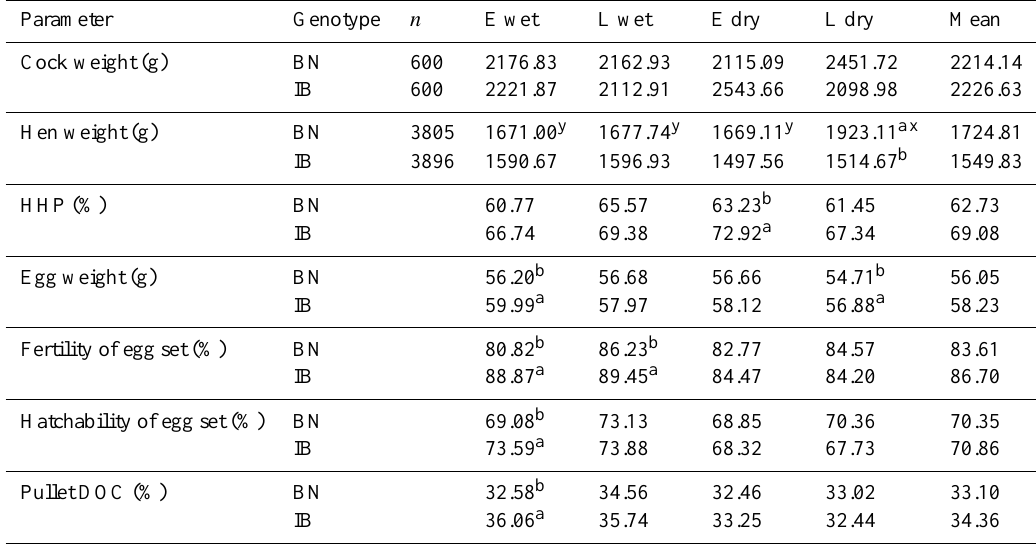
Table 3. Within-season relative sensitivity indices for Bovan Nera and ISA Brown genotypes classified by traits. Parameter Genotype E wet L wet E dry L dry Cock weight BN 1.00 1.02 1.16 0.97 IB 0.99 0.98 0.84 1.03 Hen weight BN 1.05 1.03 1.06 1.01 IB 0.95 0.97 0.94 0.99 HHP BN 0.99 1.03 1.02 0.98 IB 1.01 0.97 0.98 1.02 Egg weight BN 0.96 1.11 1.04 0.98 IB 1.04 0.89 0.96 1.02 Fertility of egg set BN 1.40 a 1.46 a 1.36 a 0.90 IB 0.60 b 0.54 b 0.64 b 1.10 Hatchability of egg set BN 0.86